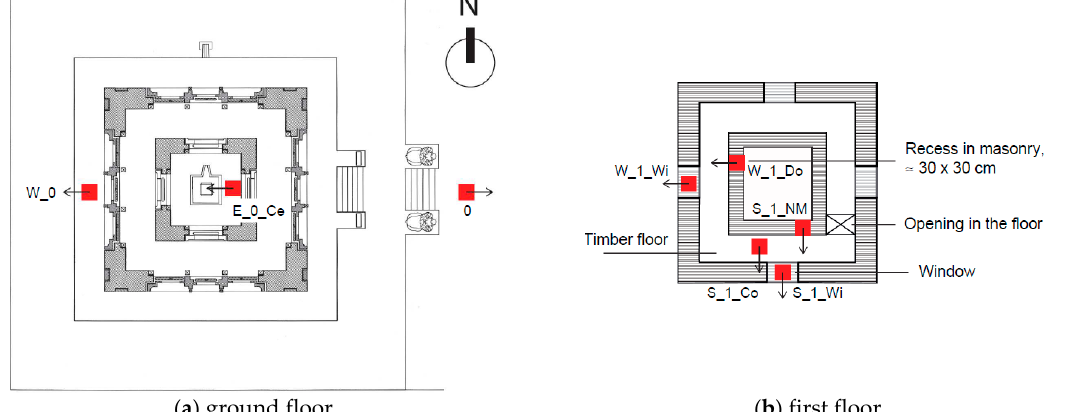
Figure 5. Locations and orientations of the velocimeter, Krishna